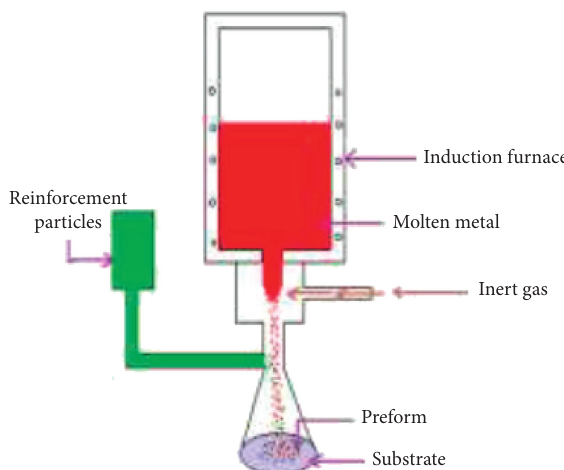
Figure 7: Schematic representation of the spray codeposition process